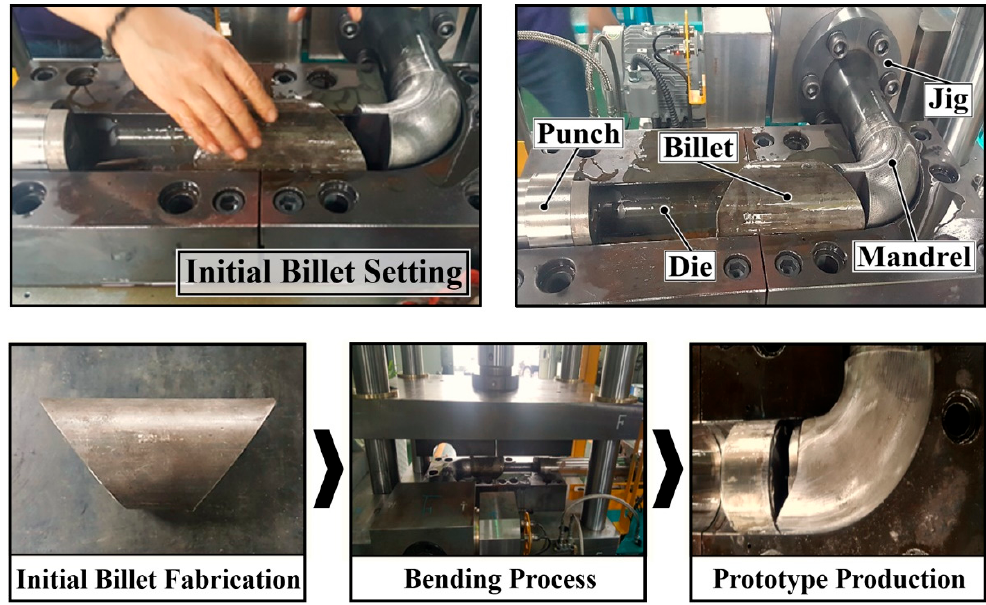
Figure 4. Fabrication process of short radius elbow.